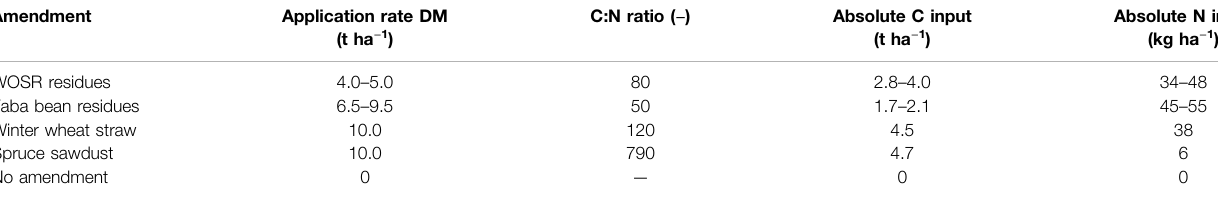
TABLE 1 | Amendment application rates and properties referring to above-ground